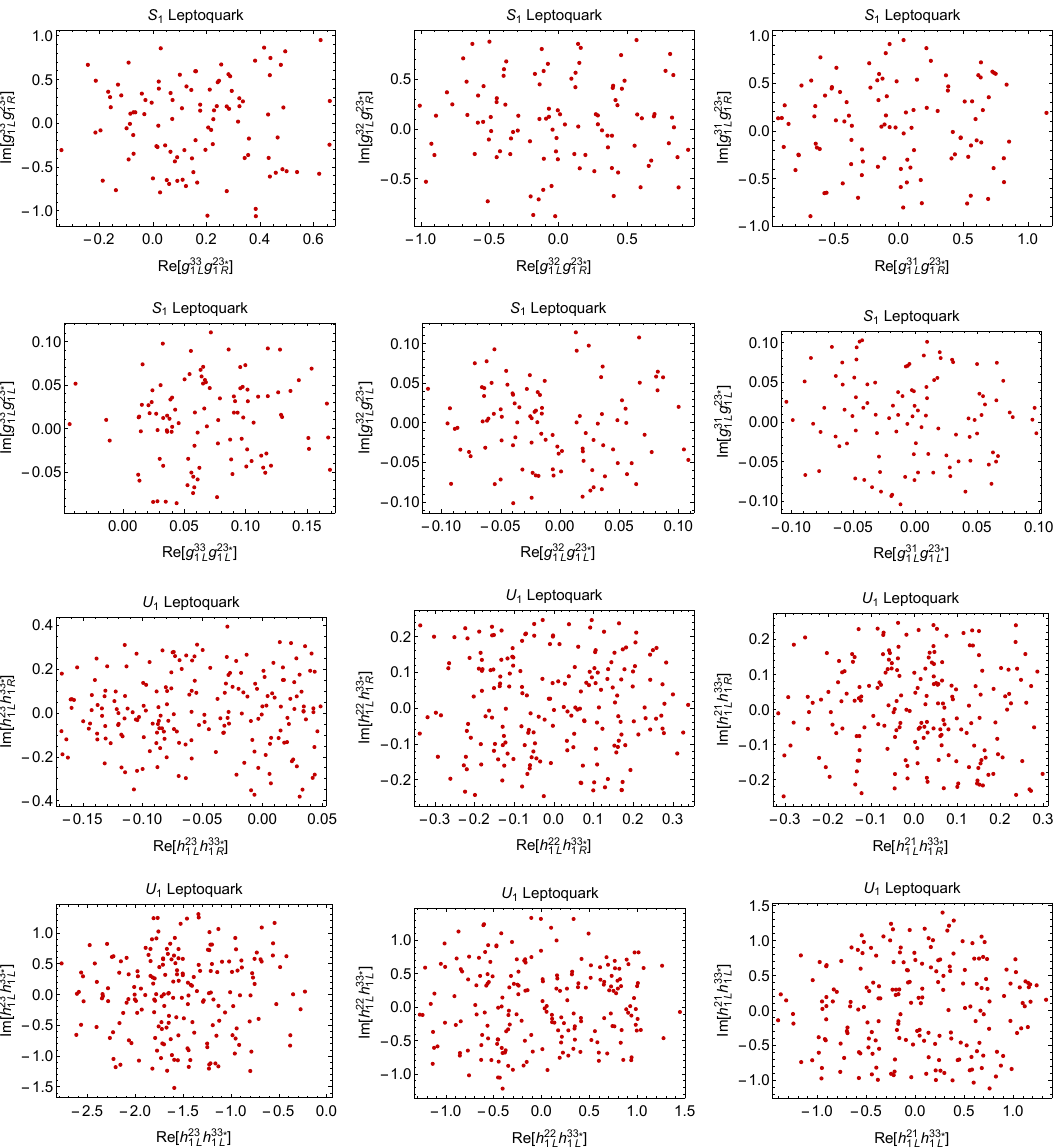
Figure 11 . Allowed regions for the couplings of the S 1 and U 1 leptoquark models in the case that all relevant couplings in each model are included simultaneously. We require that the couplings reproduce the measurements of R Ratio and R Ratio in eqs. (1.7) and (1.8) within 3 σ , satisfy ( B c D D ∗ B → τ − ¯ ν τ ) 30%, and are consistent with the upper bounds on ( B K ( ∗ ) ν ¯ ν ) at 90% C.L (the latter ≤ B → is only relevant for the left-handed couplings in the S 1